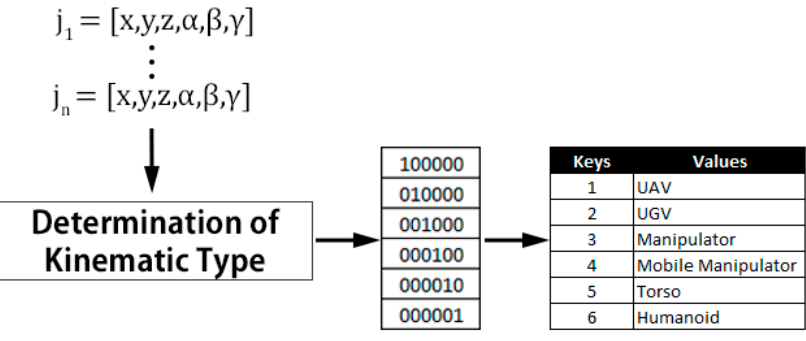
Figure 6. Formatting Robot Kinematic Type data, j i represents robot joints, x , y , z represent joint locations, and α , β , γ represent robot joint rotations.